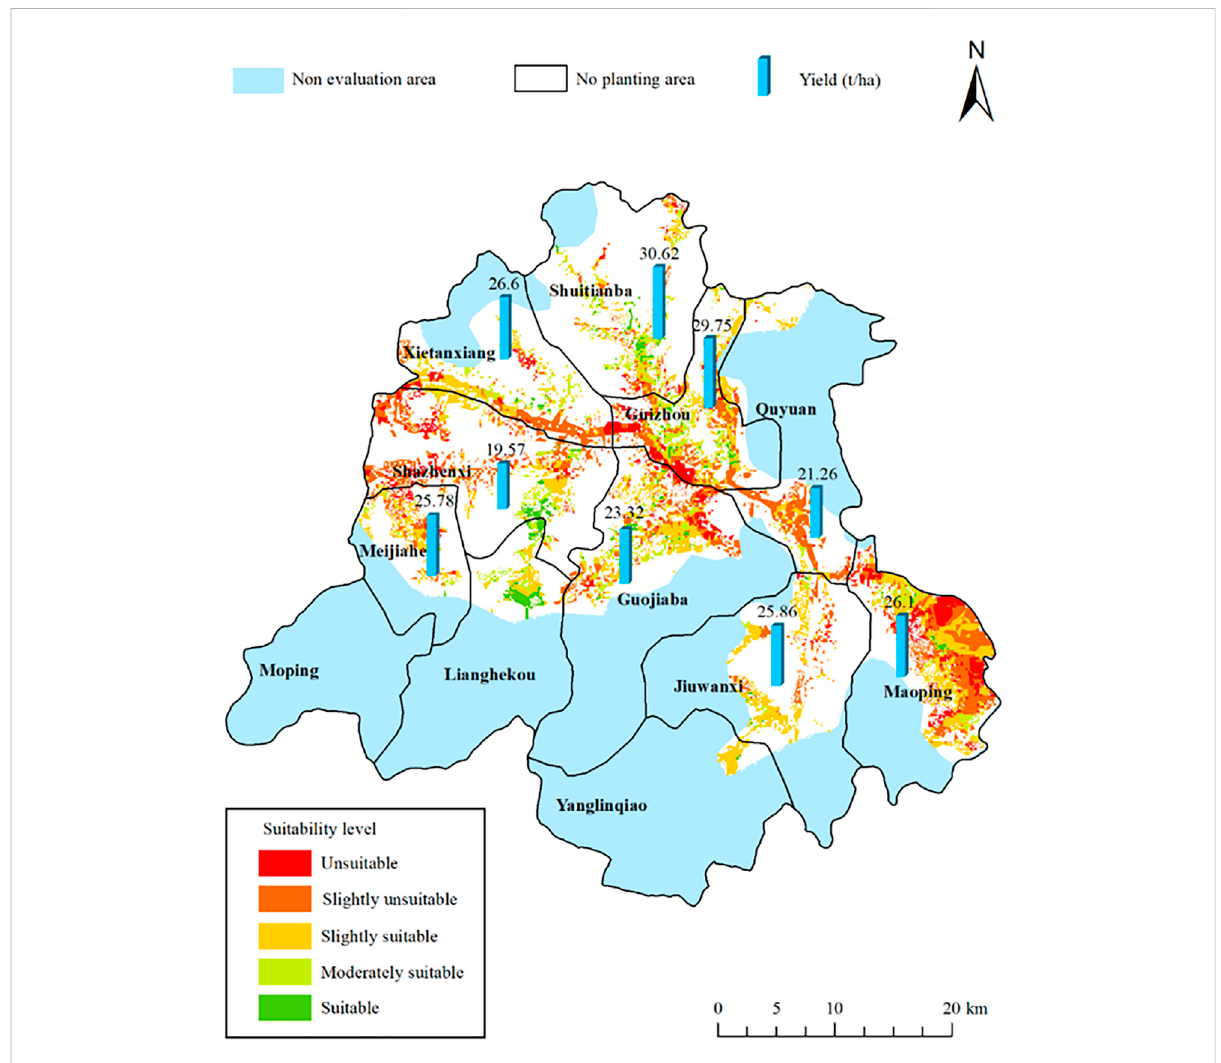
FIGURE 4 Correlations of environmental suitability with citrus yield in Zigui